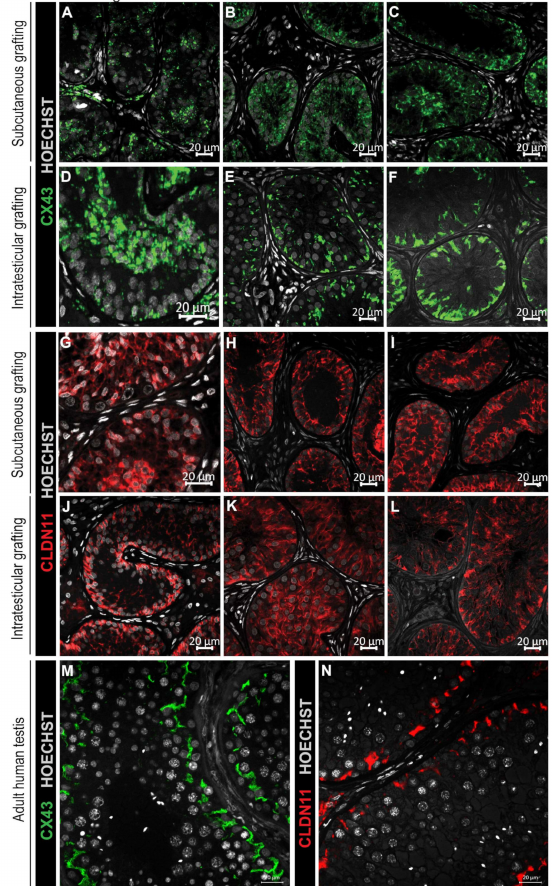
Figure 6. Expression of CX43 and CLDN11 in prepubertal human testis grafts. ( A – C ) Immature CX43 expression profile in subcutaneous grafts (pre-graft control; 1-year-old). ( D – F ) Partially mature CX43 expression profile in intratesticular grafts (pre-graft control; 14-year-old). ( G – I ) Immature CLDN11 expression pattern in subcutaneous grafts (pre-graft control; 1-year-old). ( J ) Partially mature CLDN11 expression pattern (pre-graft control; 14-year-old). ( K , L ) Immature CLDN11 expression pattern in intratesticular grafts. ( M , N ) Expression of CX43 and CLDN11 in adult human testis